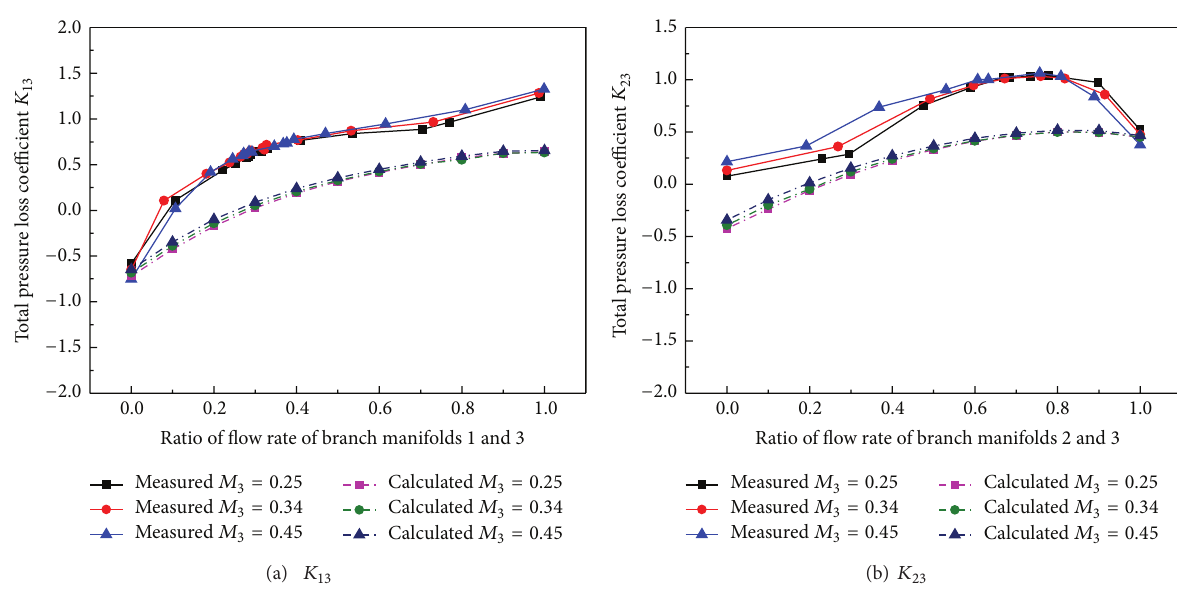
Figure 13: Comparison of total pressure loss coefficient between calculated and measured